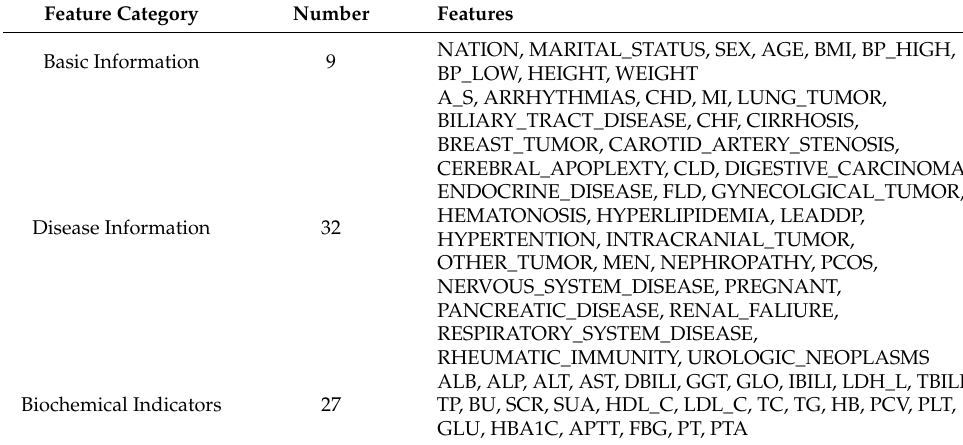
Table 1. All features of the